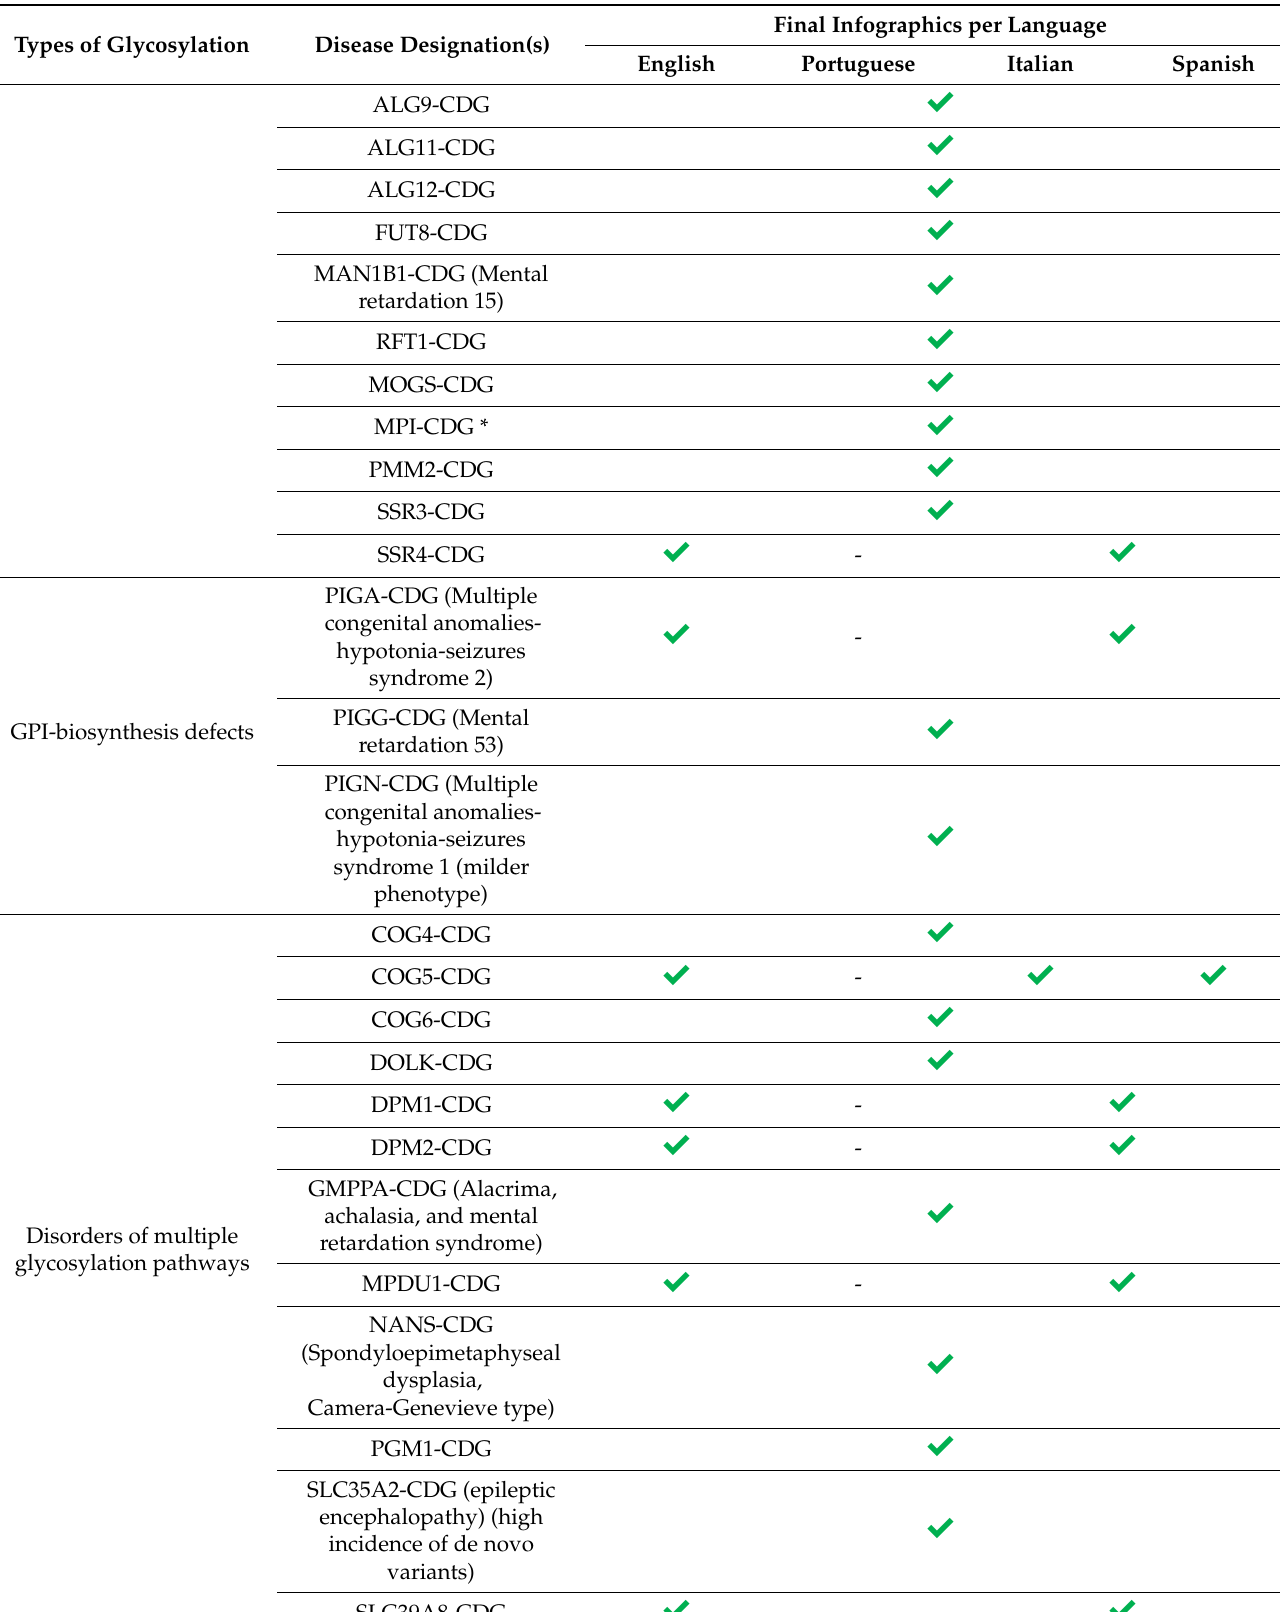
Table 3. Finished CDG infographics by different types of glycosylation.